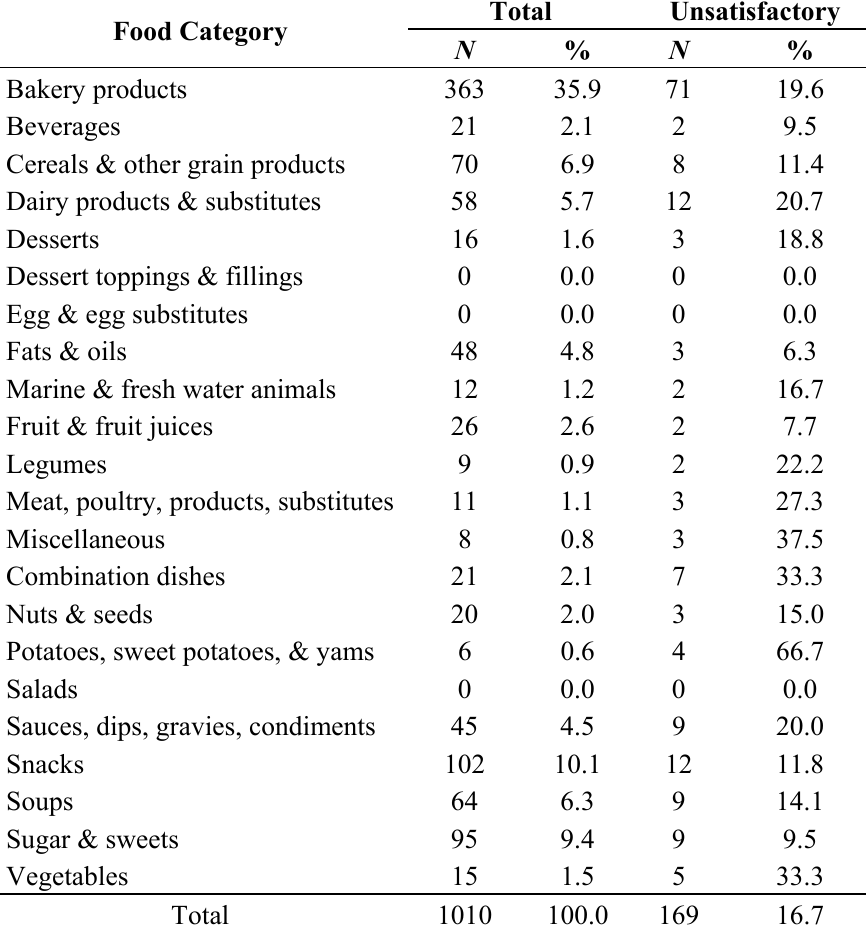
Table 4. Frequency of unsatisfactory products by food